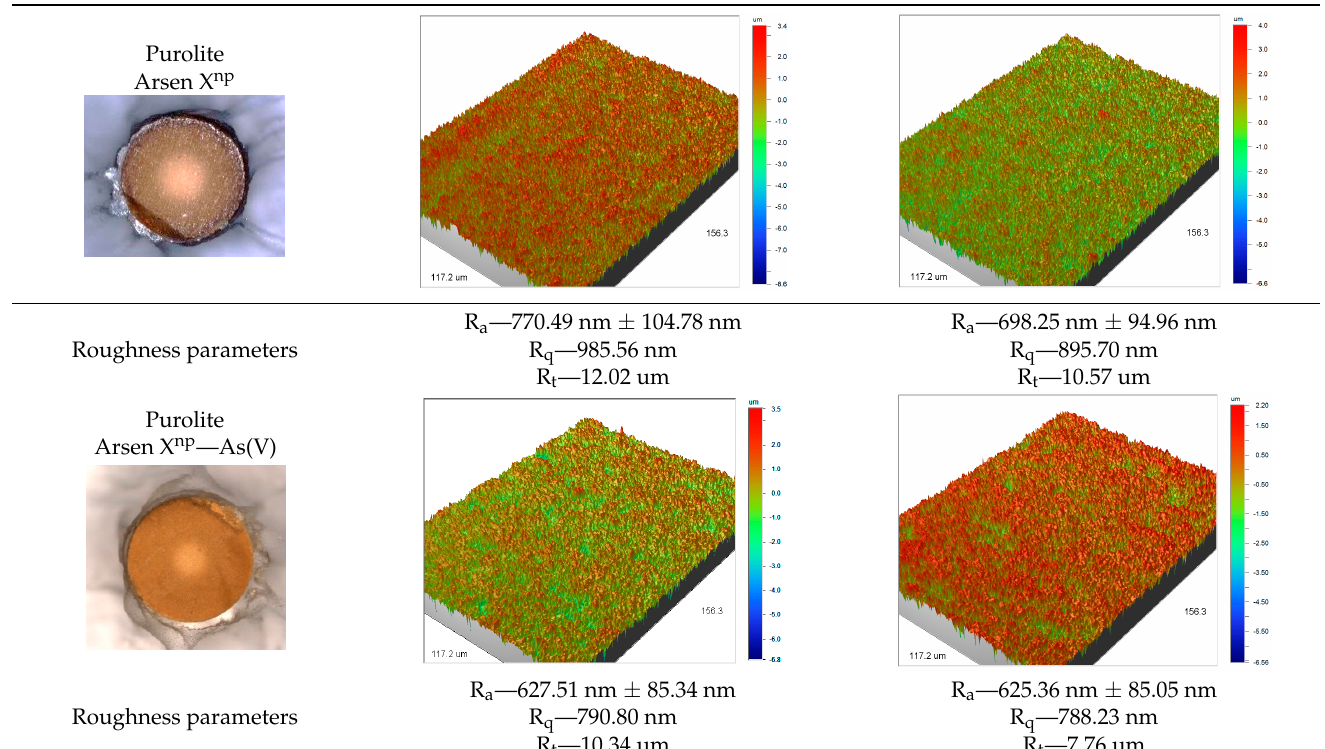
Table 5. Surface microgeometry and roughness parameters of Purolite Arsen X np before and after the sorption of As(V).